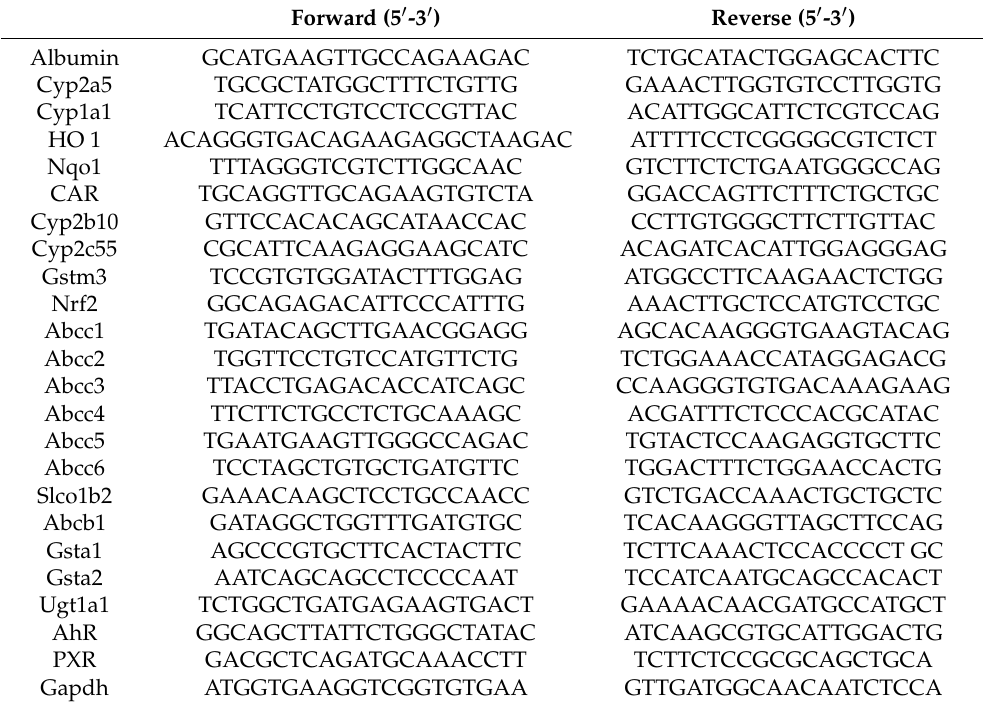
Table 1. Primer sequences for